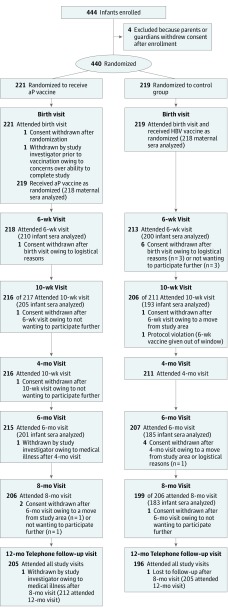
Flowchart of Study PopulationThe numbers of infants approached, assessed for eligibility, and primarily excluded are unknown. aP indicates acellular pertussis; HPV, hepatitis B vaccine.